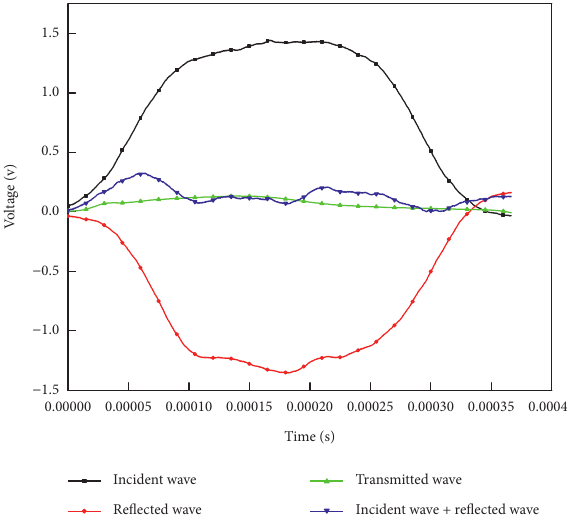
Figure 4: Stress equilibrium diagram.